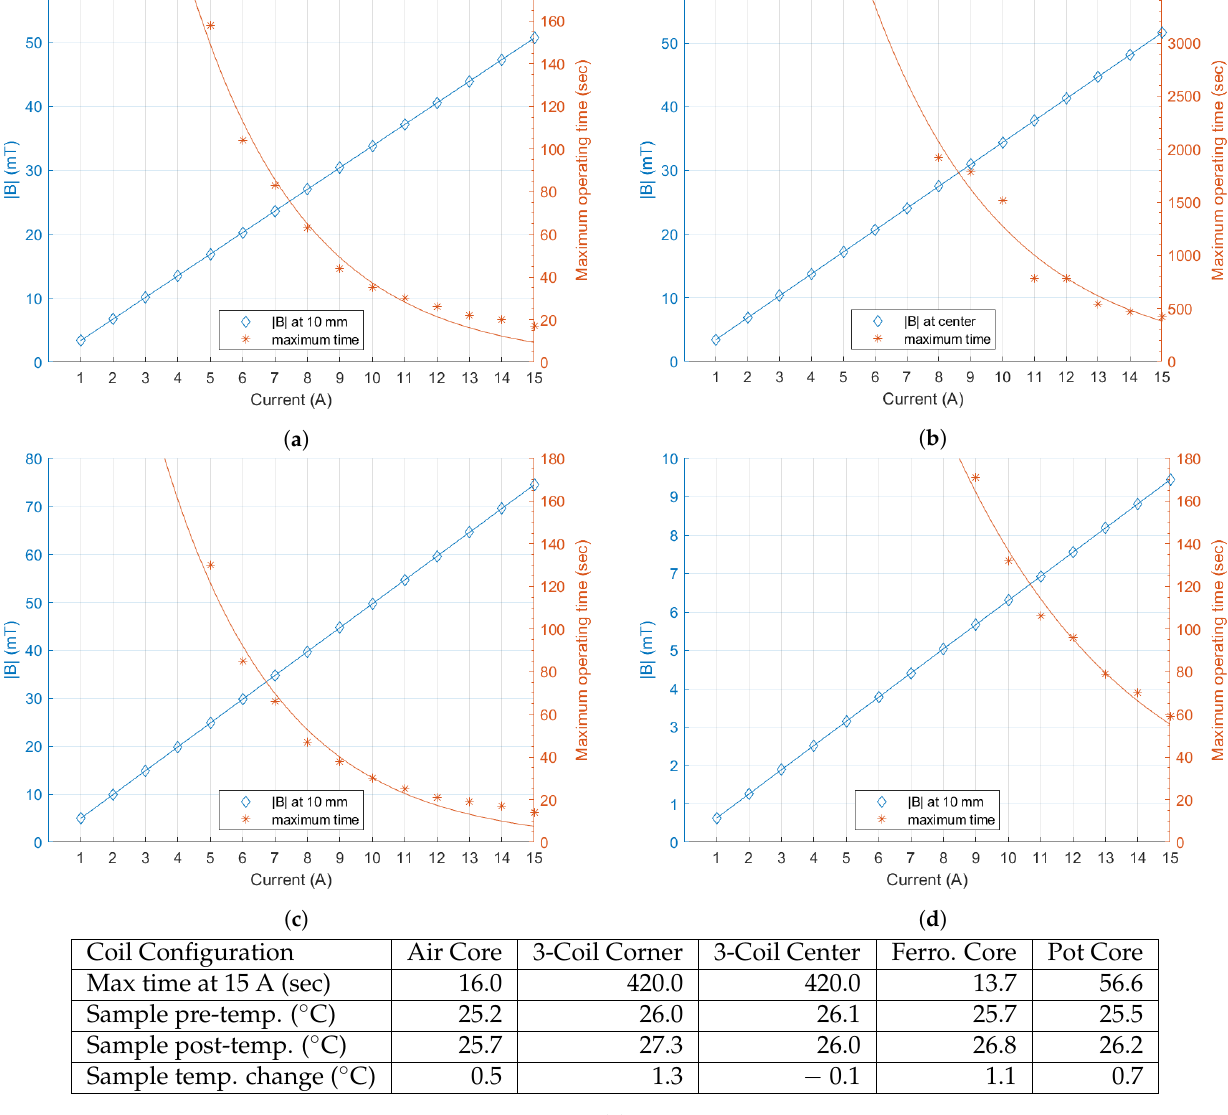
Figure 6. | B | at 10 mm from the coil or the center for the three-coil system, shown on the left axis for a range of 1 to 15 Amperes for the ( a ) air core coil; ( b ) three-coil system; ( c ) ferromagnetic core coil; and ( d ) pot core coil. In addition, the maximum operating time along the right axis for the same conditions is shown. Operating times are shown only up to one hour for the three-coil system and three minutes for the remaining geometries; ( e ) summary of the device operating times and sample temperatures for each coil